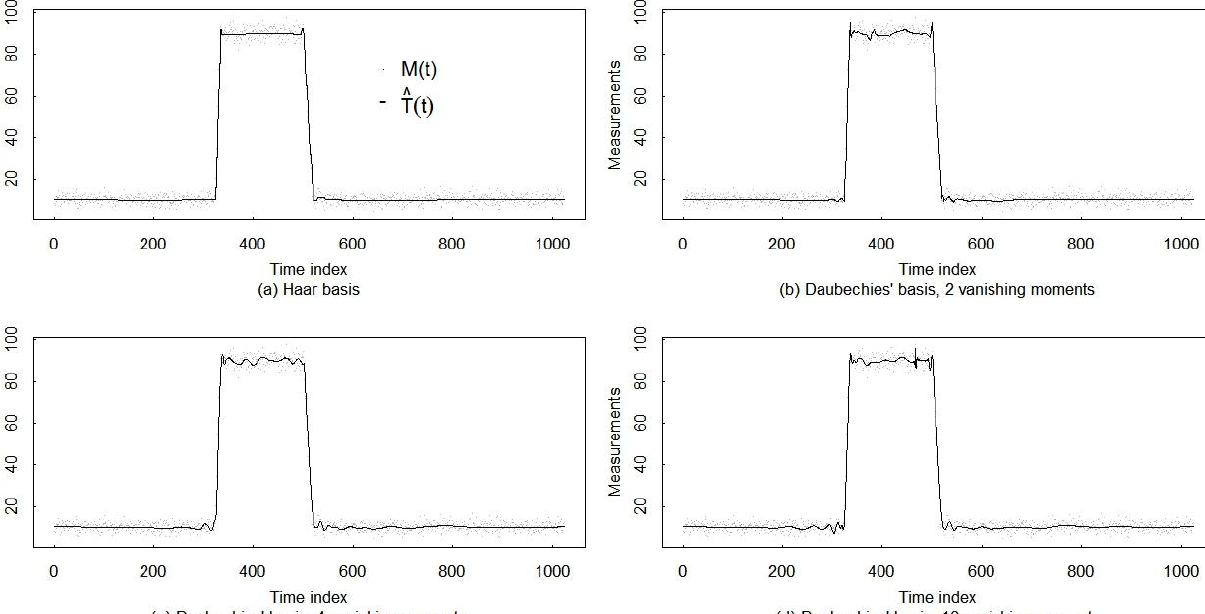
Figure 2. Comparison of the Gibbs phenomenon for various